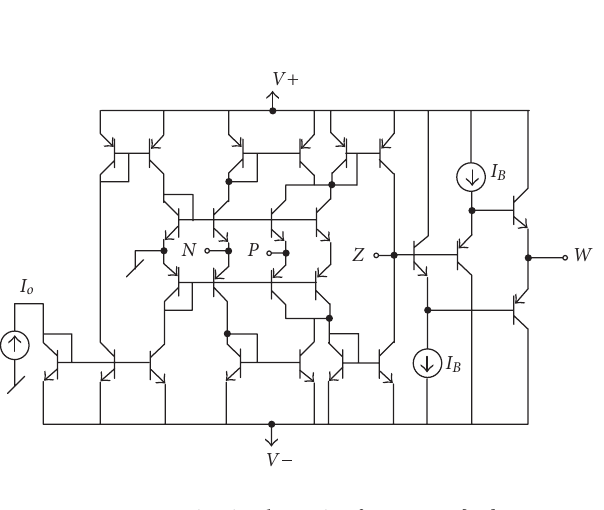
Figure 4: Circuit schematic of CCCDBA [10].